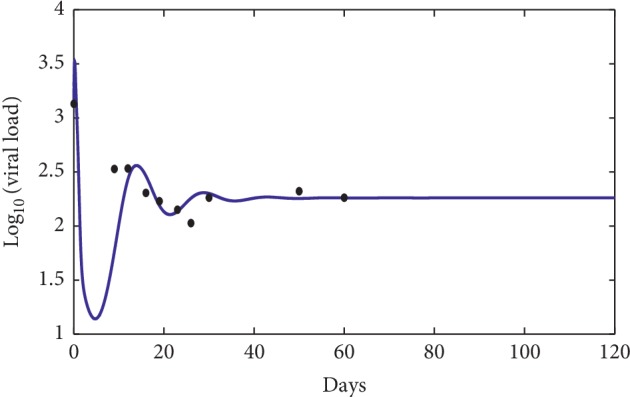
Comparison between the mathematical model (solid line) and the clinical data of the seventh patient [18] (dots). The used parameters for the model are λ=10, d1=0.0139, k1=0.05, d2=0.0495, k2=1.1, d3=0.5776, a=600, d4=0.6, q=0.5, g=10−3, h=0.182, p=0.0024, c=0.15, and b=0.5.